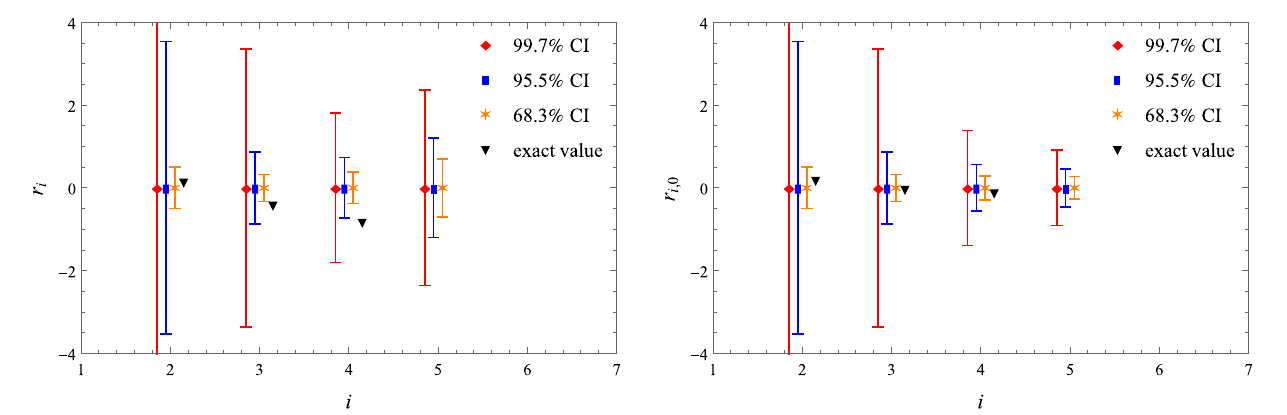
Fig. 1 The predicted credible intervals (CI) with three typical DoBs for the scale-dependent coefficients r i (μ r ) at the scale μ r = Q and the scale-invariant r i , 0 of R n ( Q = 31 . 6GeV ) under the Bayesian- based approach, respectively. The red diamonds, the blue rectangles,